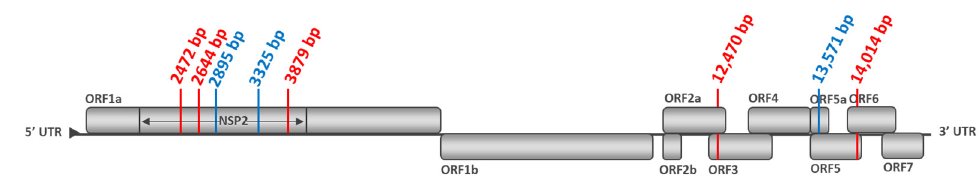
Figure 9. Localization in the PRRSV-1 genome of the identified mutations potentially linked to the adaptation (colored in blue) or the loss of attenuation (colored in red) phenomenon of the Porcilis ® PRRS DV strain after limited passages in pigs during Trial#1 and Trial#2. The KF991509.2 full-ge- nome sequence of Porcilis ® PRRS modified live vaccine of type 1 (MLV1) DV strain is used as refer- ence